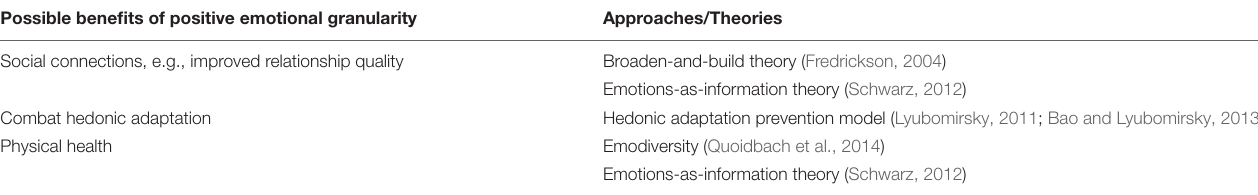
TABLE 1 | Hypothesized benefits of positive emotional granularity and supporting theoretical approaches. Possible benefits of positive emotional